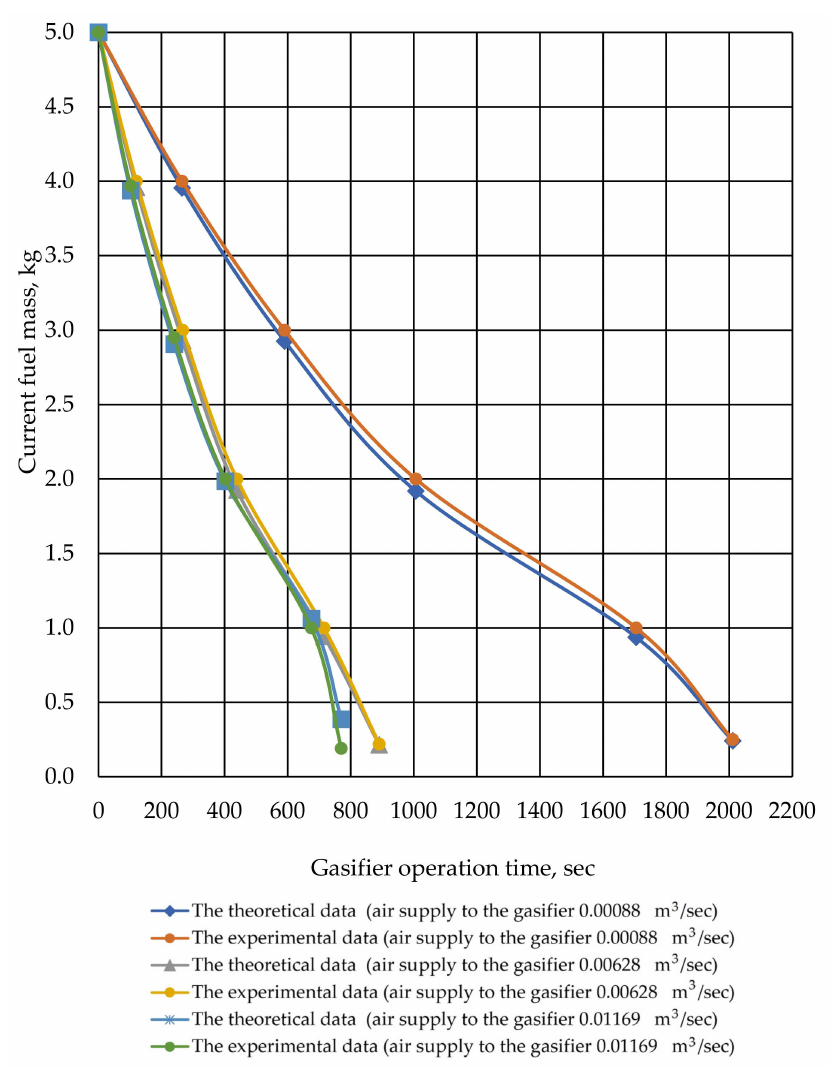
Figure 2. Comparison of the experimental and theoretical indicators of the change of fuel mass when using wood